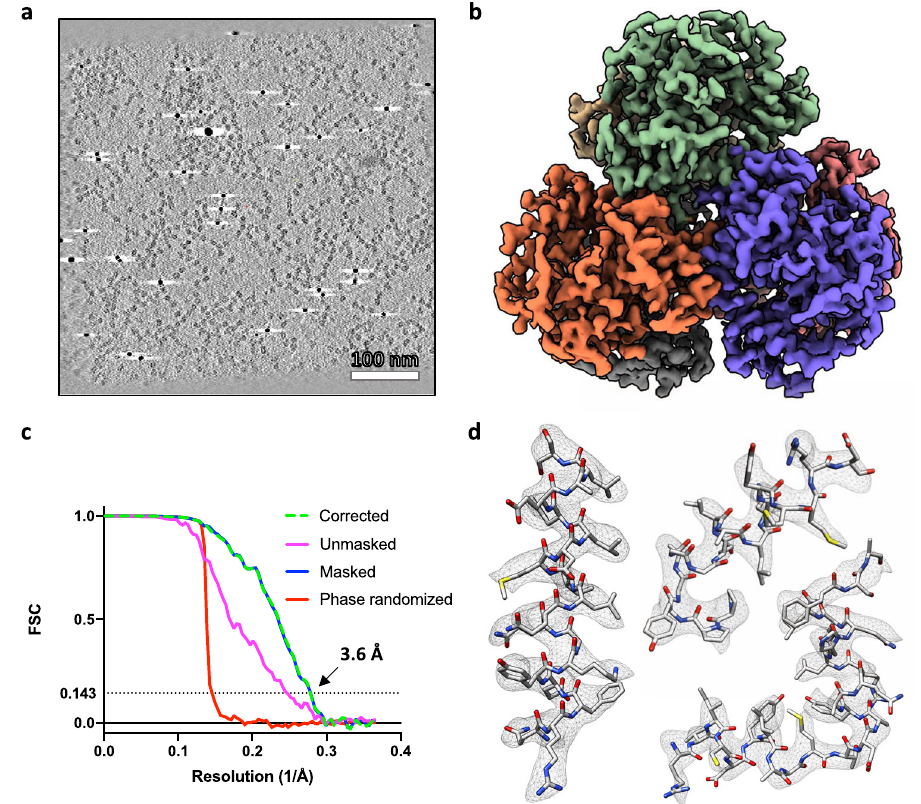
Fig. 5 Near-atomic resolution structure of 300 kDa complex using BISECT/CSPT. a Representative 50 nm-thick slice through tomographic reconstruction showing individual dNTPase particles (a total of 64 tomograms were used). Scale bar 100 nm. b Overview of dNTPase map obtained from ~30k particles extracted from 64 low-dose tomographic tilt-series. c Fourier Shell Correlation plots between half-maps showing an estimated resolution of 3.6 Å according to the 0.143-cutoff criteria. Curves corrected for masking effects (green dashed line), unmasked (magenta), masked (blue), and phase randomized (red) are shown. d Regions of the density map and fi tted atomic coordinates showing the visualization of side chains. 3D re fi nement and reconstruction were repeated independently three times yielding structures with similar